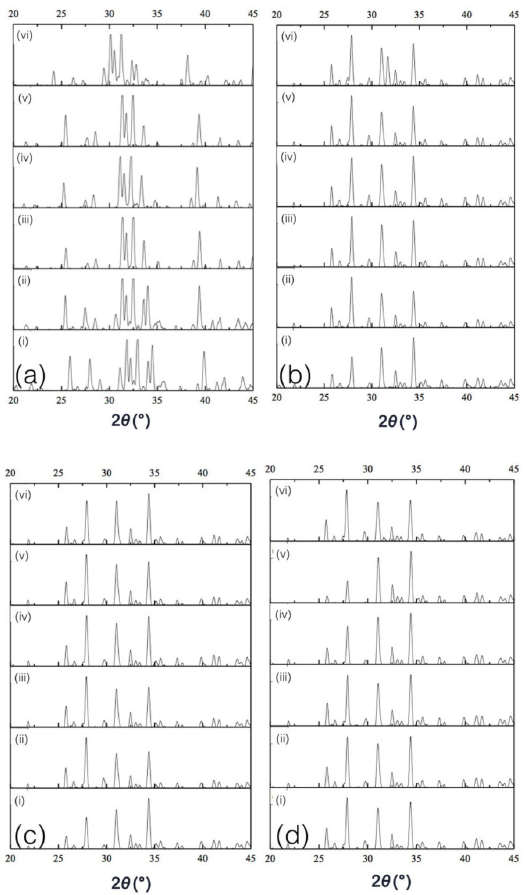
Fig. 4 (a) Ca concentration and (b) PO 4 concentration in 0.05 mol/L Tris buffer after immersion of 100% HA, 100% β-TCP, 15%/85% HA/β-TCP, and 15%/85% HA/β-TCP (design) for time periods ranging from 1 to 336 h (14 days).